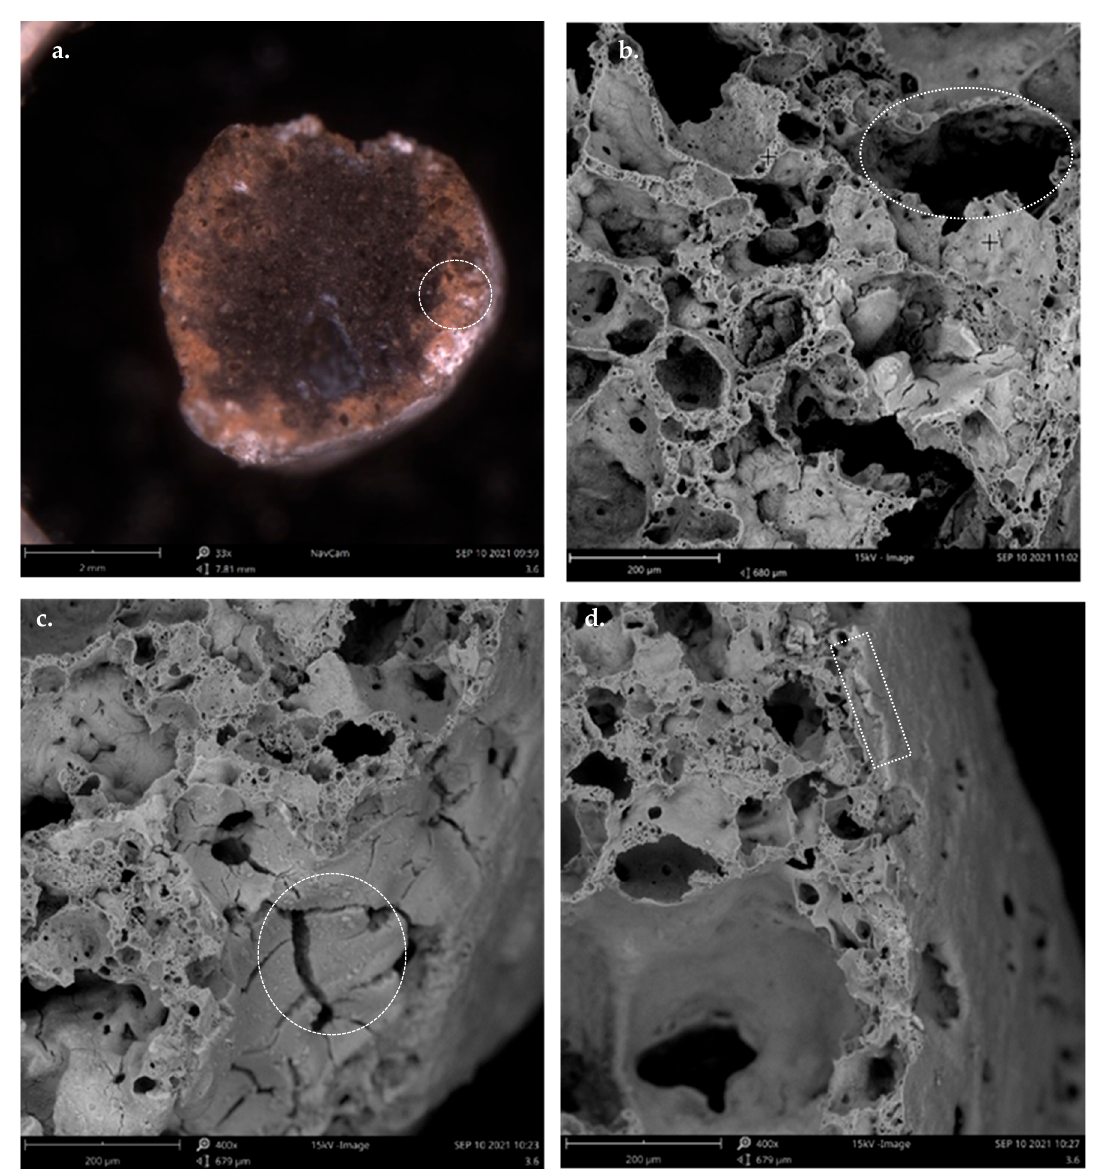
Figure 7. ( a ) Cross-section of the photocatalyst, 3.6%-TiO 2 /Leca; ( b ) image of the central area of a Leca particle; ( c , d ) TiO 2 layer on the Leca surface.